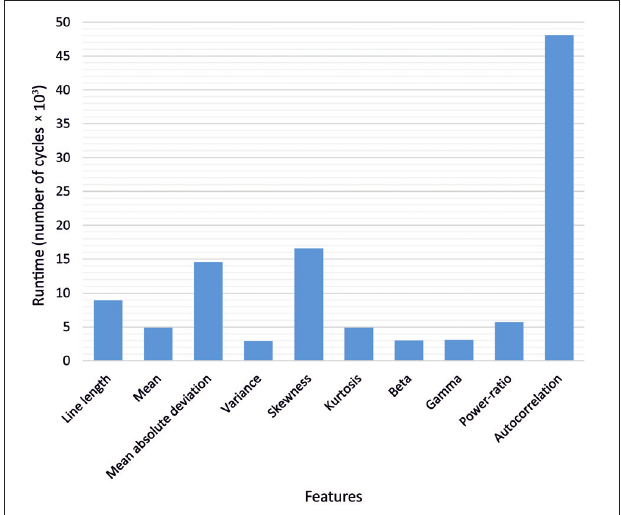
FIGURE 8 | Required runtime in number of cycles for each